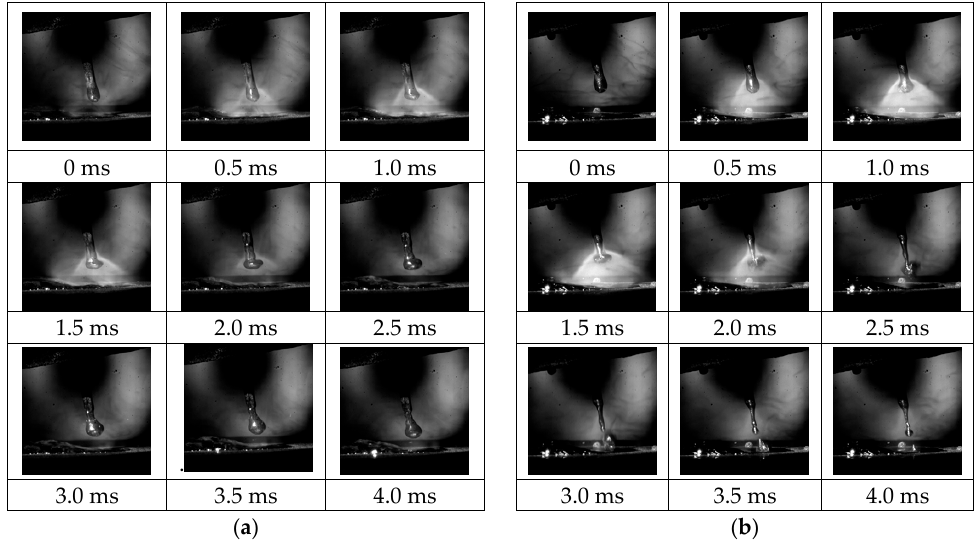
Figure 11. High ‐ speed images during the pulse mode welding: ( a ) AZ31 ‐ A; ( b ) AZ31 ‐ B. Figure 11. High-speed images during the pulse mode welding: ( a ) AZ31-A; ( b )